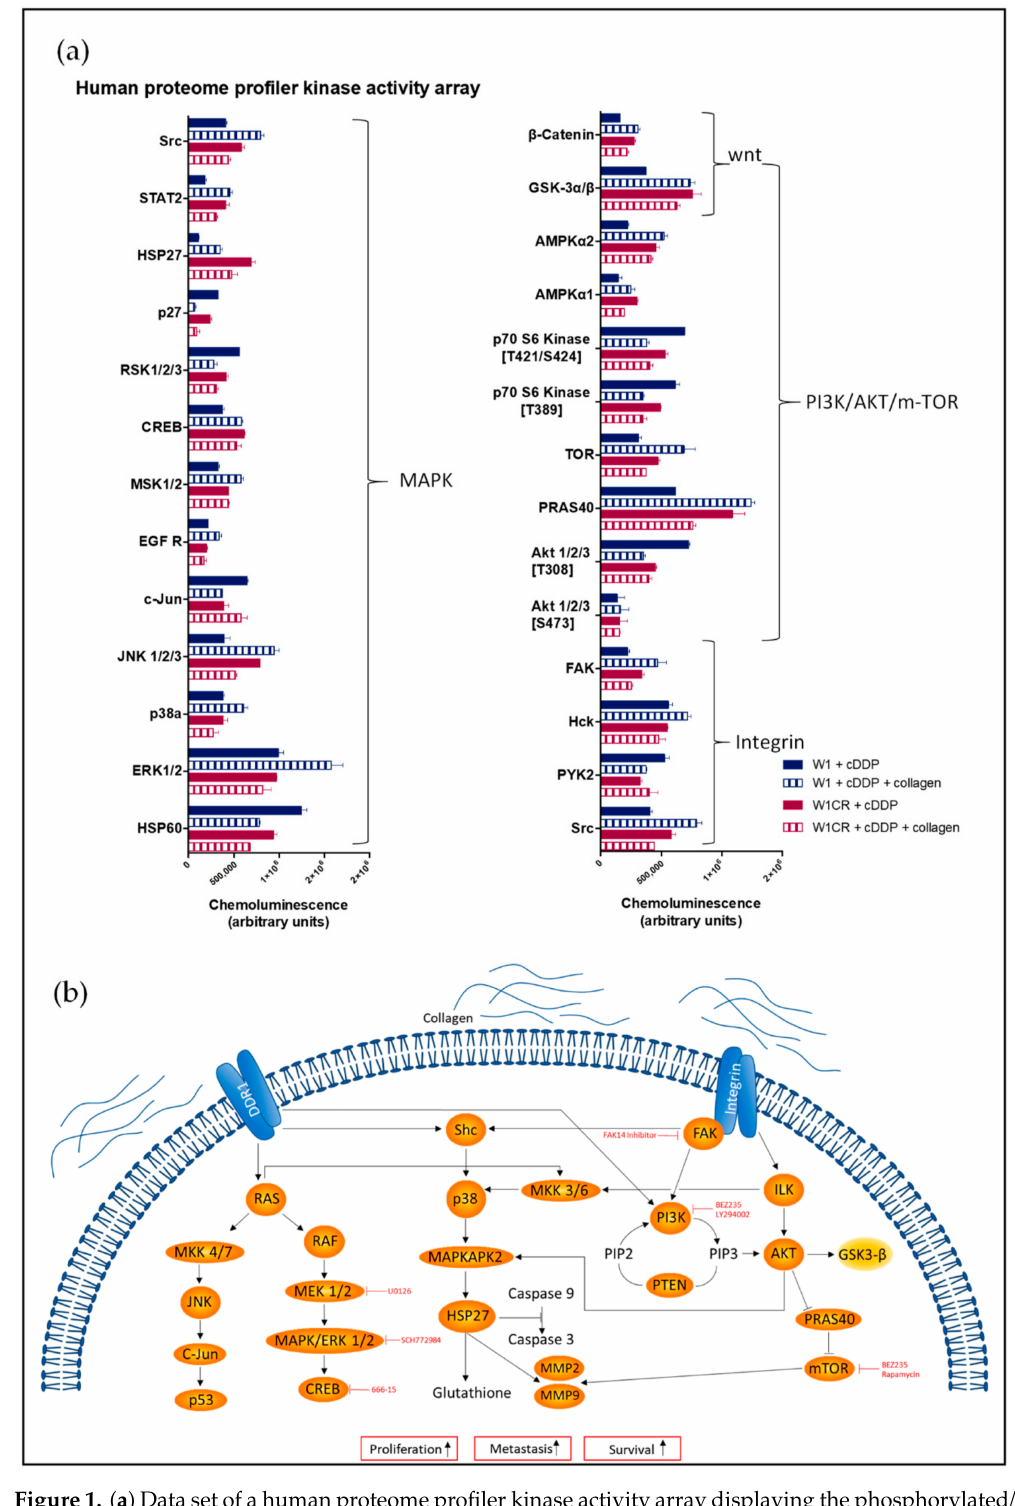
Figure 1. ( a ) Data set of a human proteome profiler kinase activity array displaying the phosphorylated / activated form of the components in cisplatin (cDDP)-treated W1 and W1CR cells with and without collagen ( n = 1). ( b ) Overview of the investigated signaling pathway and inhibitory